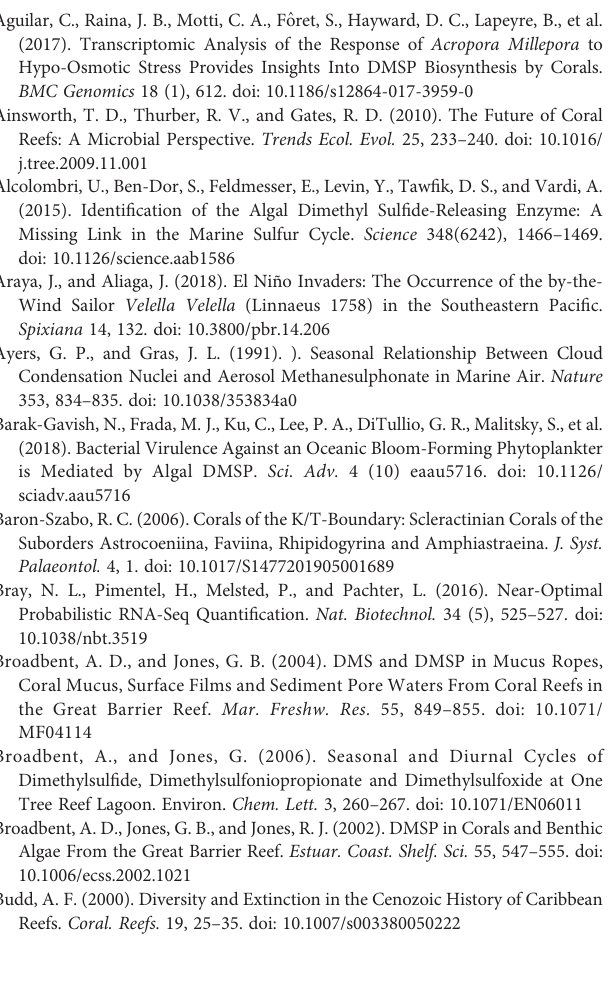
Supplementary Figure 3 | Maximum likelihood analysis of DL-L genes identi fi ed from transcriptomic databases of cnidarians. A total of 65 DL-L genes from cnidaria